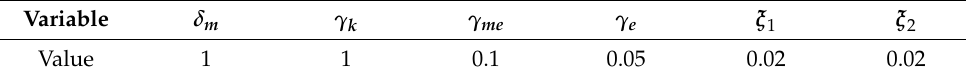
Table 1. The nondimensionalized parameters of the lumped